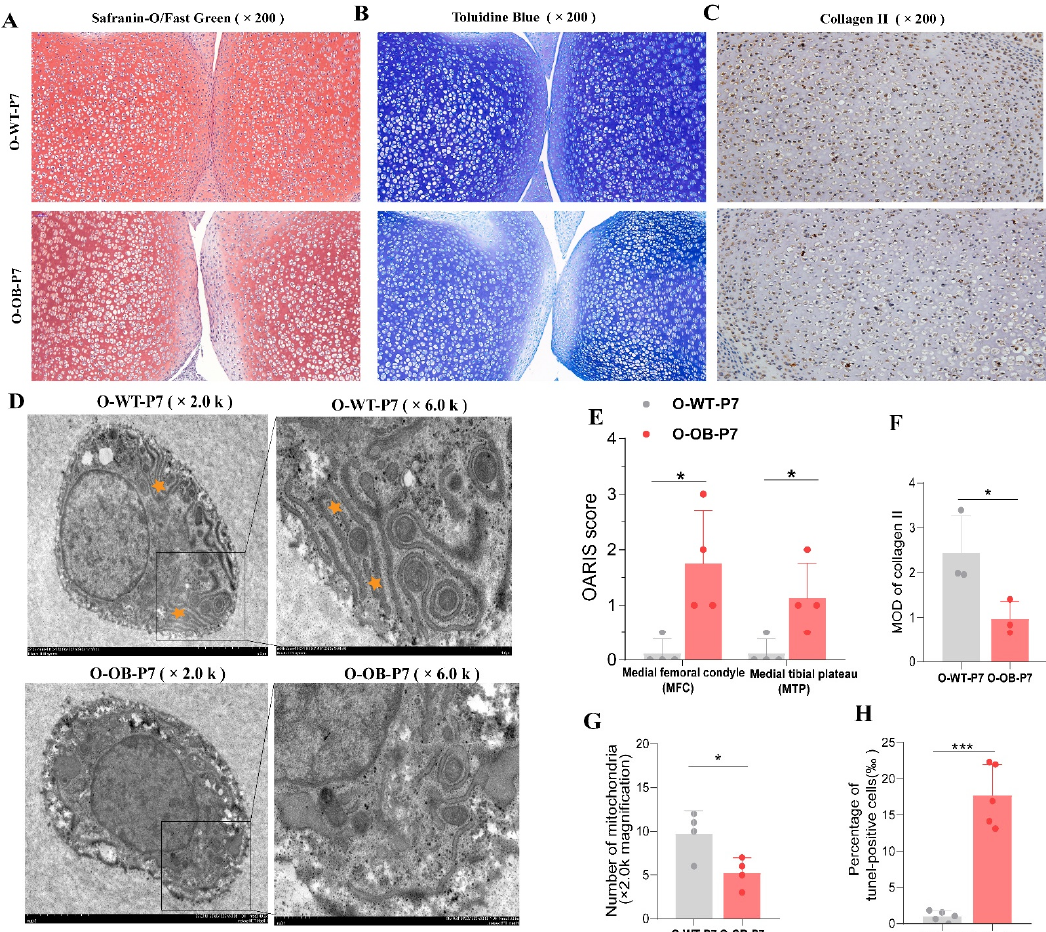
Figure 2. Effect of maternal obesity on knee cartilage in the offspring 7 ‐ day male mice. ( A ) Representative images of knee cartilage stained with Safranin O/Fast Green and ( B ) toluidine blue in con ‐ trol versus obese offspring (×200 magnification, n = 4). ( C ) Representative images of IHC ‐ stained in collagen II knee cartilage in control versus obese offspring (×200 magnification, n = 3). ( D ) Ultra ‐ structural observation of knee chondrocytes in control versus obese offspring ( n = 4). ( E ) Statistical results of the OARIS scores of knee cartilage in the offspring of each group. ( F ) Statistical results of IHC ‐ stained collagen II in each group. ( G ) Statistical results of mitochondrial count in chondrocytes by transmission electron microscopy ( n = 4). ( H ) Statistical results of the positive rate of TUNEL staining of knee cartilage in each group ( n = 5). O ‐ WT ‐ P7: offspring 7 ‐ day male mice from the control mothers. O ‐ OB ‐ P7: offspring 7 ‐ day male mice from the obese mothers. Yellow stars mean developed endoplasmic reticulum. Results are expressed as mean ± SD. * p < 0.05, *** p < 0.001.